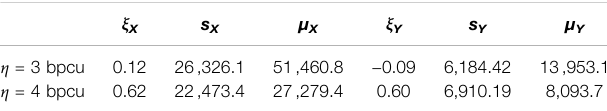
TABLE 4 | PDF approximation parameters for the hybrid architecture.